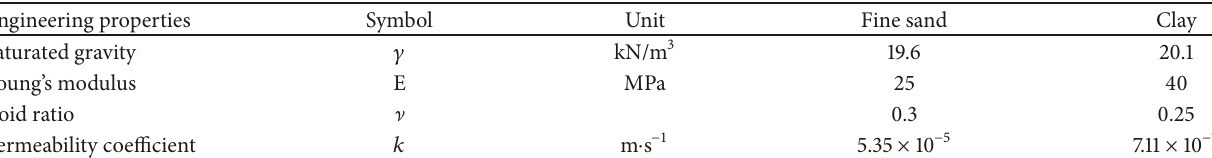
Table 5: Material parameters used in FEM simulation.